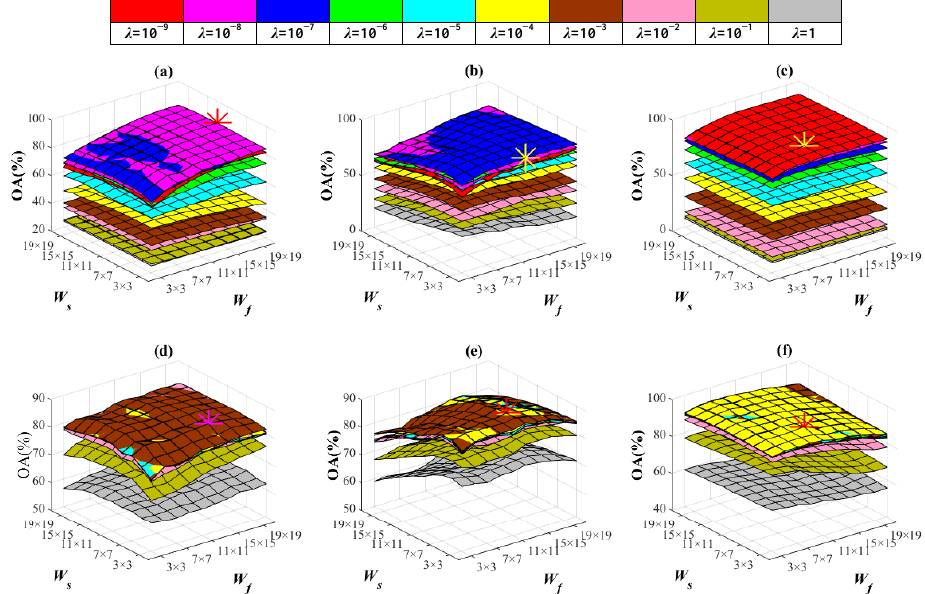
Figure 9. Classification performance under different parameters: ( a ) WSSJCRC and ( d ) WSSJKCRC on the Indian Pines scene, ( b ) WSSJCRC and ( e ) WSSJKCRC on the Pavia University scene, and ( c ) WSSJCRC and ( f ) WSSJKCRC on the Salinas scene. Table 3. Optimal parameter settings for the proposed WSSJCRC and WSSJKCRC methods on the Indian Pines, Pavia University, and Salinas scenes.